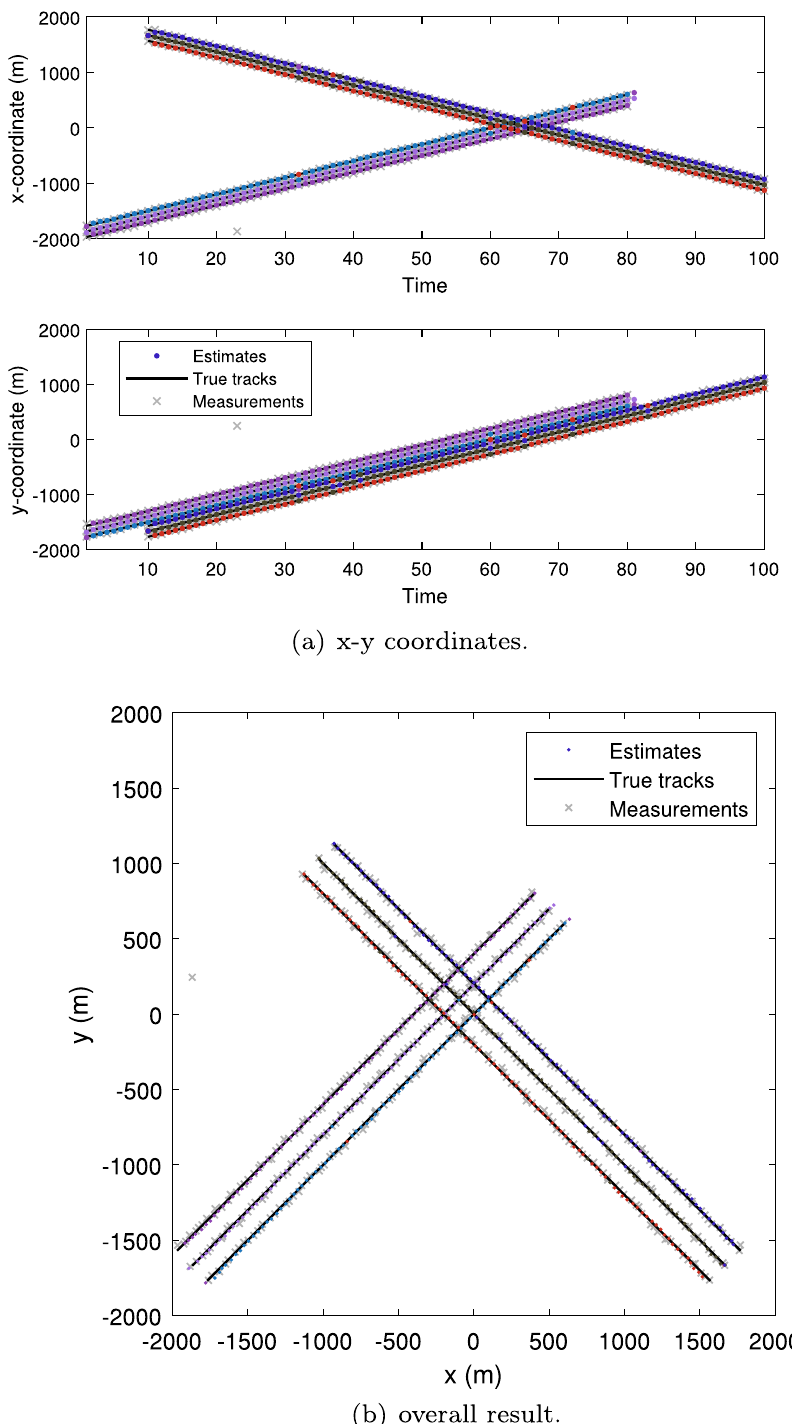
Fig. 14 States estimation of all